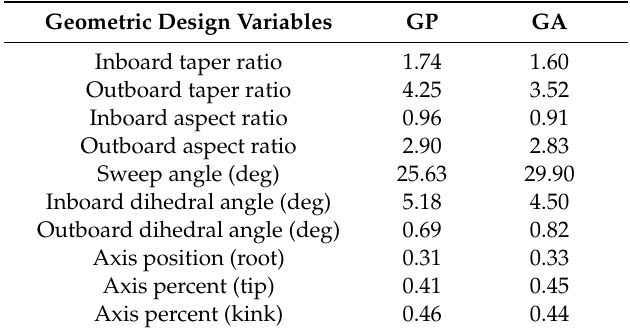
Table 4. Geometric parameters and elastic axis position